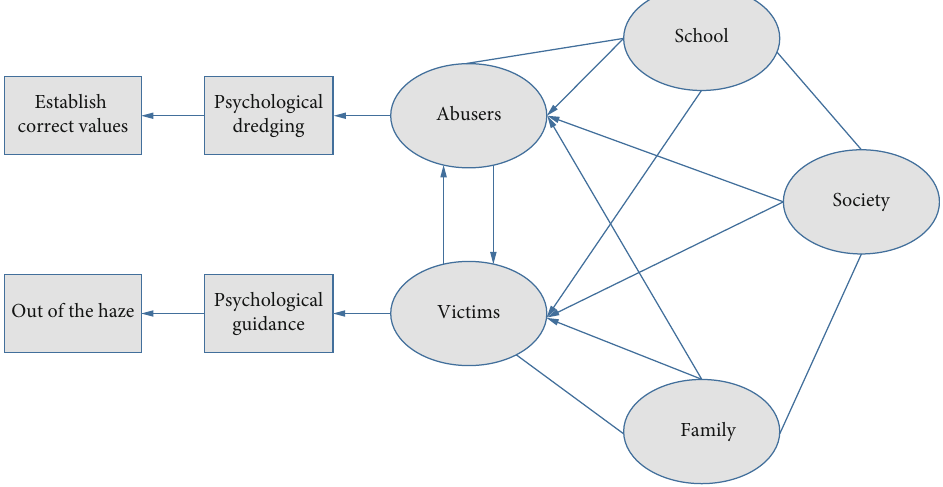
Figure 5: Perpetrator-victim occupational therapy education